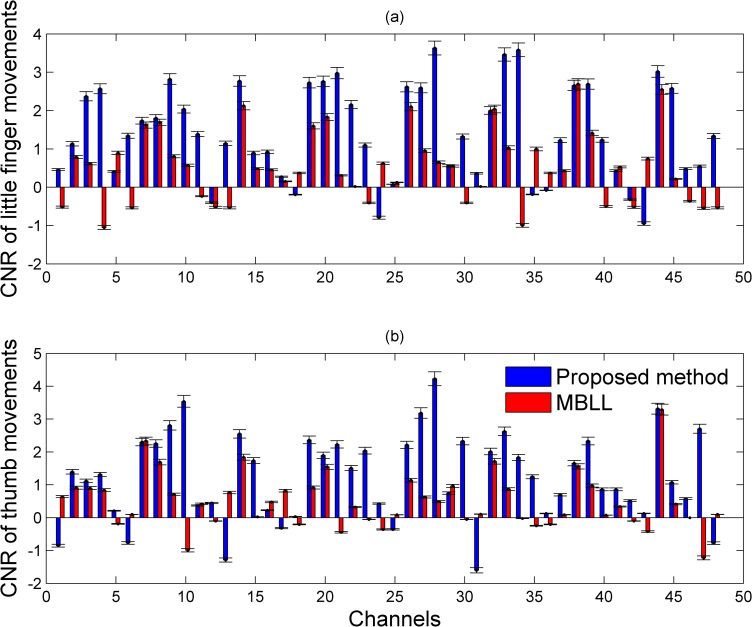
Comparison of the CNRs of HbOs in 48 channels (Subject 5).(a) The CNR of little movements; (b) the CNR of thumb movements: Red bars are the CNRs of HbOs computed by the conventional MBLL method whereas blue bars indicate the CNRs of those calculated by the proposed approach.